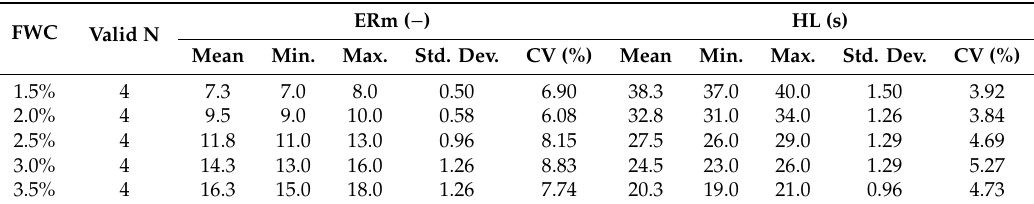
Table 10. Foaming performance of the reference 35 / 50 penetration